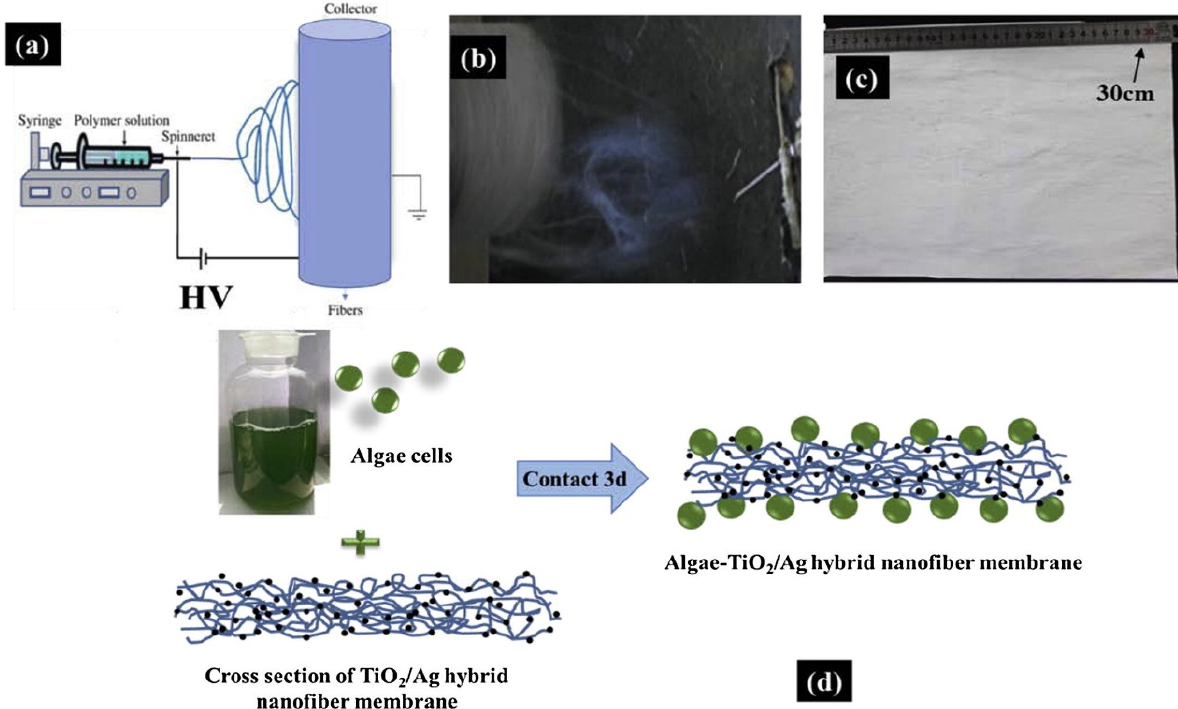
Figure 2. ( a ) Schematic illustration of electrospinning system, ( b ) nanofibers generation by single needle electrospinning, ( c ) demonstration of large-scale nanofibers mat and ( d ) scheme modeling the preparation of algae decorated TiO 2 /Ag hybrid nanofiber membrane. Reprinted with permission from [24].